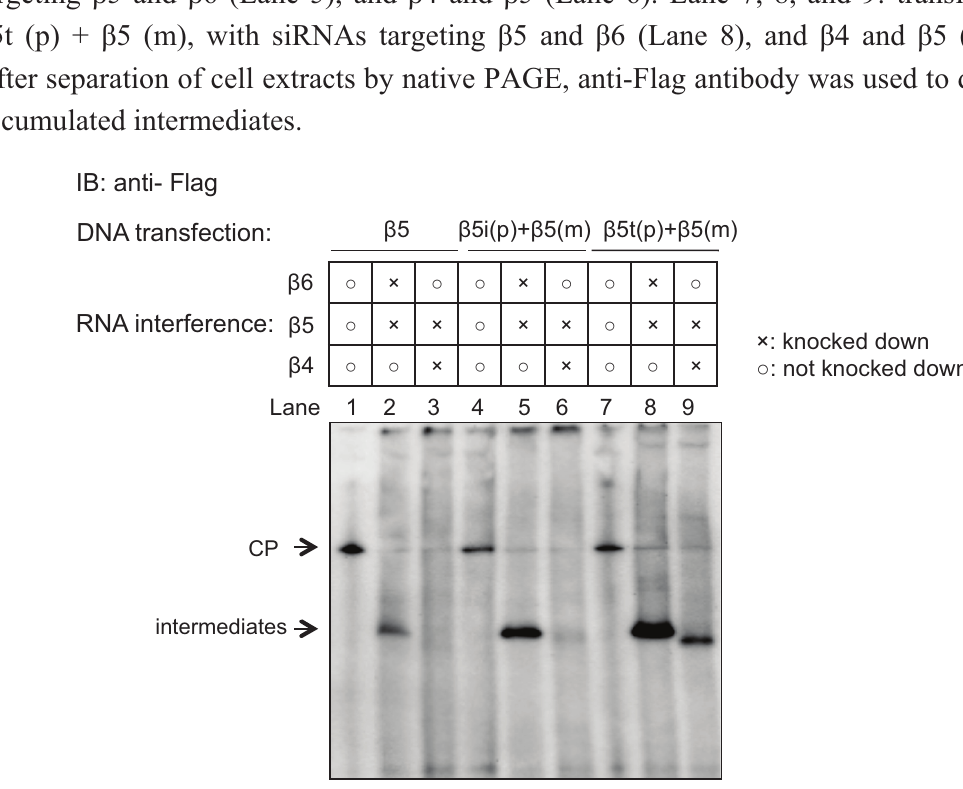
Figure 5. Roles of the propeptide of (cid:2)5i and (cid:2)5t in the earlier incorporation. (cid:2)5, (cid:2)5i (p) + (cid:2)5 (m), and (cid:2)5t (p) + (cid:2)5 (m) with C-terminal Flag tags were expressed in the HEK293T cells. (cid:2)4 was knocked down to check the earlier incorporation of the wild-type and mutant (cid:2)5. Lane 1, 2, and 3: transfection of (cid:2)5 with silent mutation that cannot be targeted by siRNA. siRNAs targeting endogenous (cid:2)5 and (cid:2)6 (Lane 2), and endogenous (cid:2)4 and (cid:2)5 (Lane 3) were further performed; Lane 4, 5, and 6: transfection of (cid:2)5i (p) + (cid:2)5 (m), with siRNAs targeting (cid:2)5 and (cid:2)6 (Lane 5), and (cid:2)4 and (cid:2)5 (Lane 6). Lane 7, 8, and 9: transfection of (cid:2)5t (p) + (cid:2)5 (m), with siRNAs targeting (cid:2)5 and (cid:2)6 (Lane 8), and (cid:2)4 and (cid:2)5 (Lane